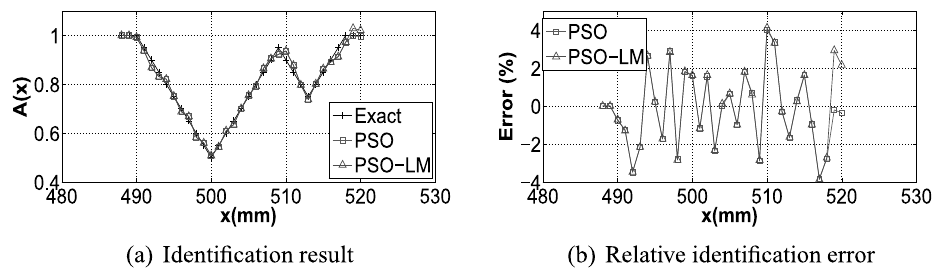
Fig. 24. Identi fi cation with SNR = 10 dB for Case 3 and long rectangular